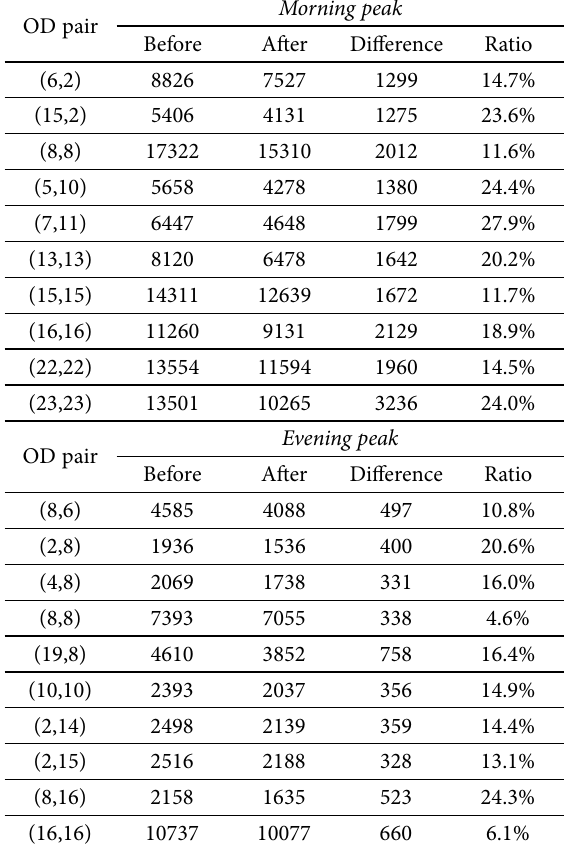
Table 3. Comparison of OD pairs before and after changing work start